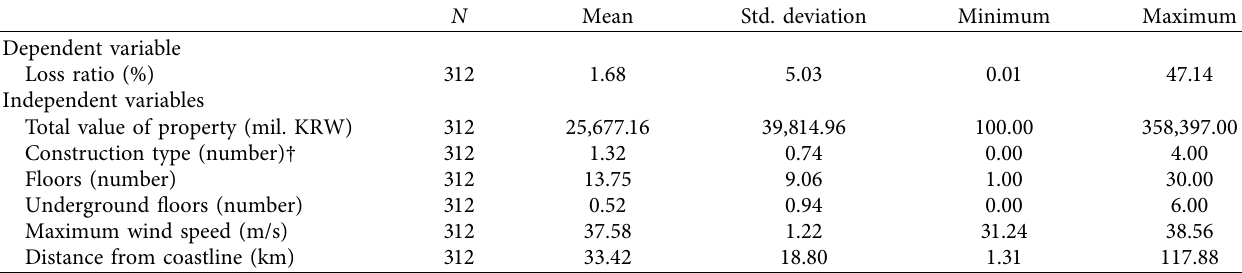
Table 2: Descriptive statistics of the